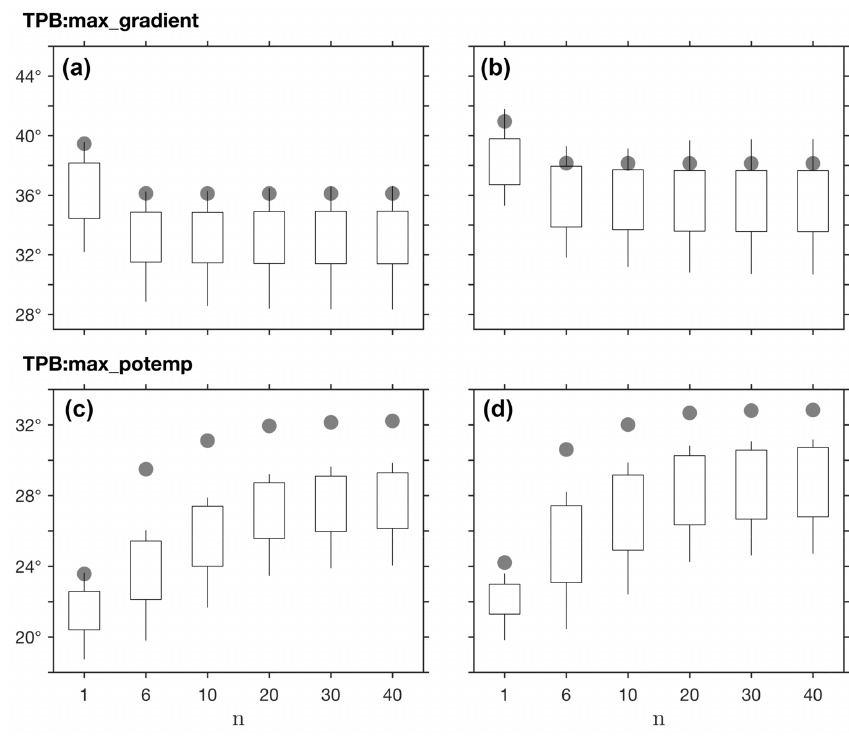
Figure 10. As in Fig. 9 for the dependence of TPB:max_gradient and TPB:max_potemp on the smoothing parameter n .